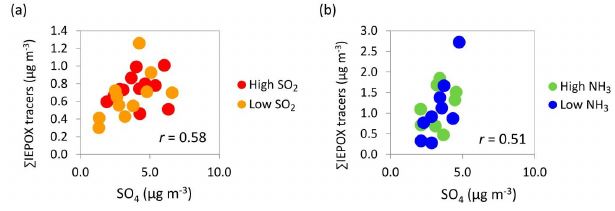
Fig. 12. Correlations between the sum of IEPOX SOA tracers and Figure 12. Correlations between the sum of IEPOX SOA tracers and the particle sulfate loadings: 708 the particle sulfate loadings: (a) SO 2 conditional samples; (b) NH 3 (a) SO 2 conditional samples (b) NH 3 conditional samples. Positive correlations were observed 709 conditional samples. Positive correlations were observed for both for both SO 2 and NH 3 conditional samples, indicating a role of particle sulfate loadings for 710 SO 2 and NH 3 conditional samples, indicating a role of particle sul- fate loadings for providing surface area that limits the IEPOX up- providing surface area that limits the IEPOX uptake and forming SOA tracers. 711 take and forming SOA tracers.